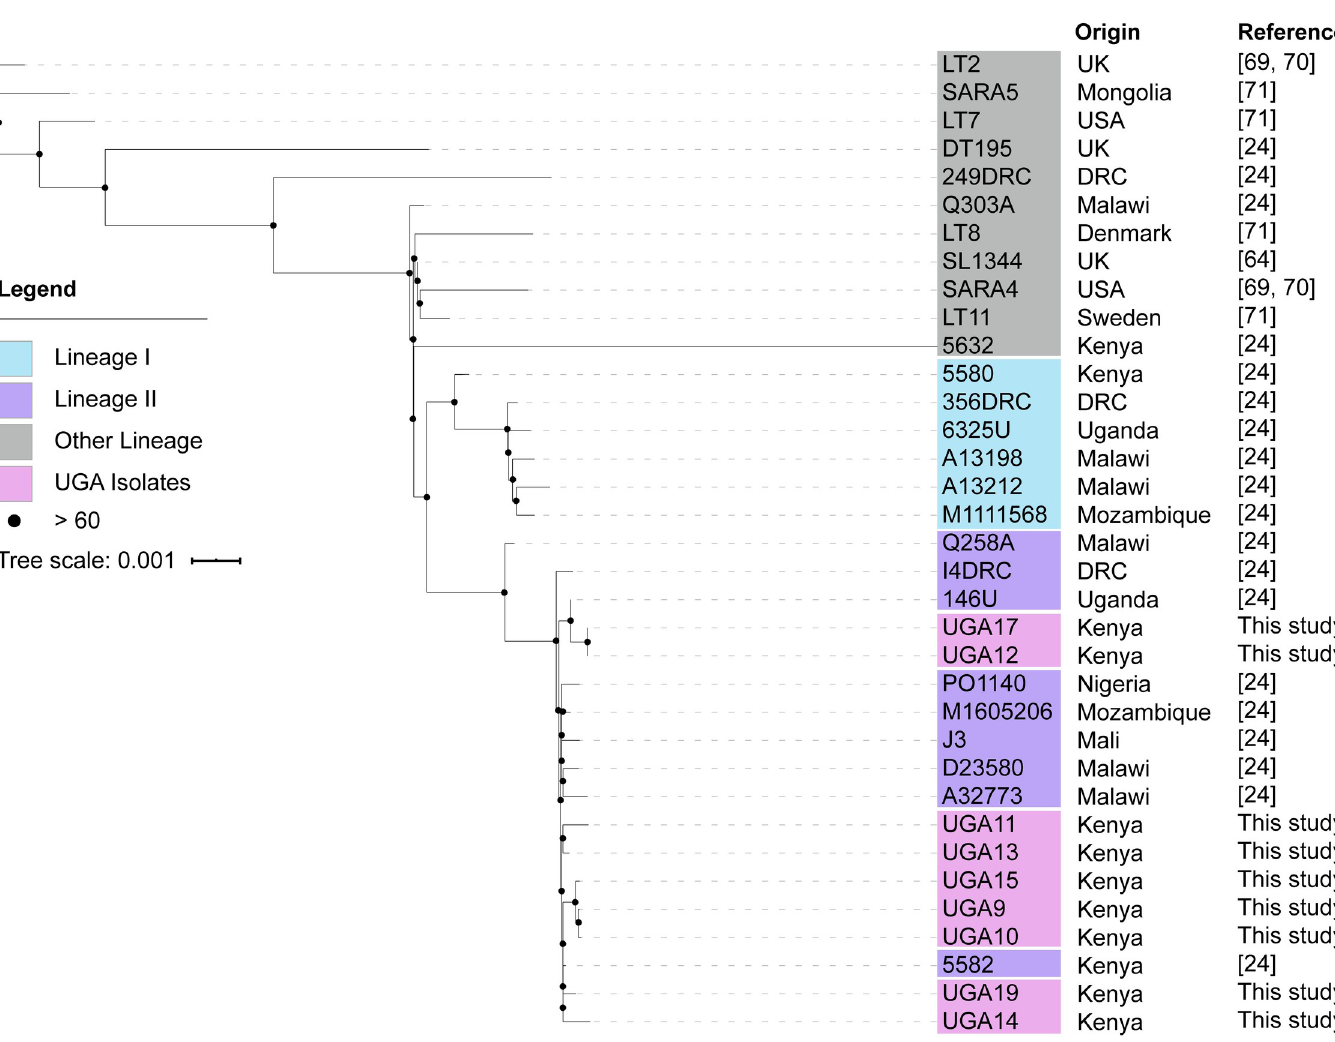
Fig 1. A maximum likelihood single-nucleotide polymorphism (SNP)–based phylogeny of S . Typhimurium isolates from Kenya between 2000 and 2011 associated with invasive disease. The strains that were sequenced as part of this study are represented as UGA followed by a number, and all other strains were previously reported by the publications indicated in the “Reference” column. Names of genomes from this study are colored in pink, isolates from lineage 1 and lineage 2 identified previously by Okoro et al . [24] are colored in cyan and purple respectively, and all other genomes are colored in gray. The tree was rooted using the midpoint method in iTOL. The scale bar indicates number of substitutions per site. Bootstrap support are labeled on branches with black dots whose size correspond to bootstrap support